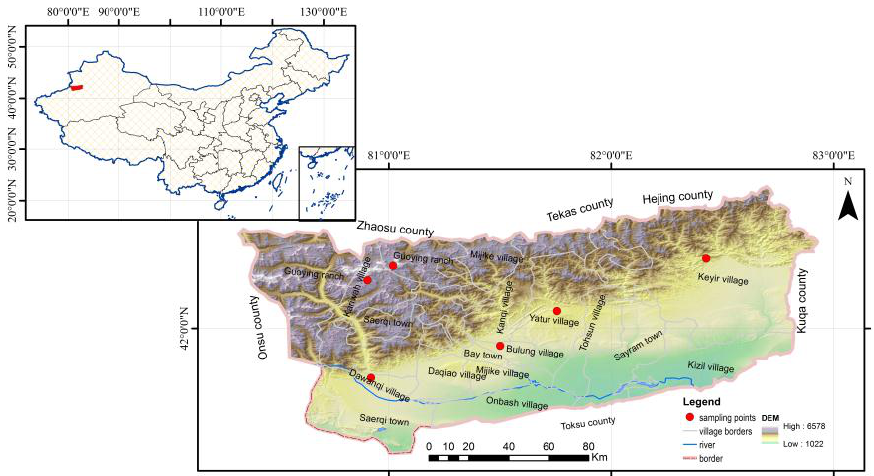
Figure 1. The study area.